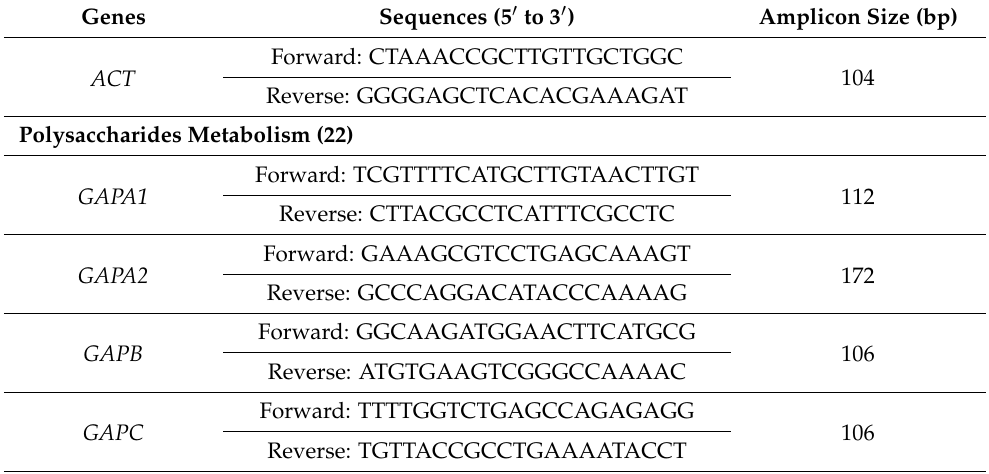
Table 2. Sequences of primer employed in qRT-PCR